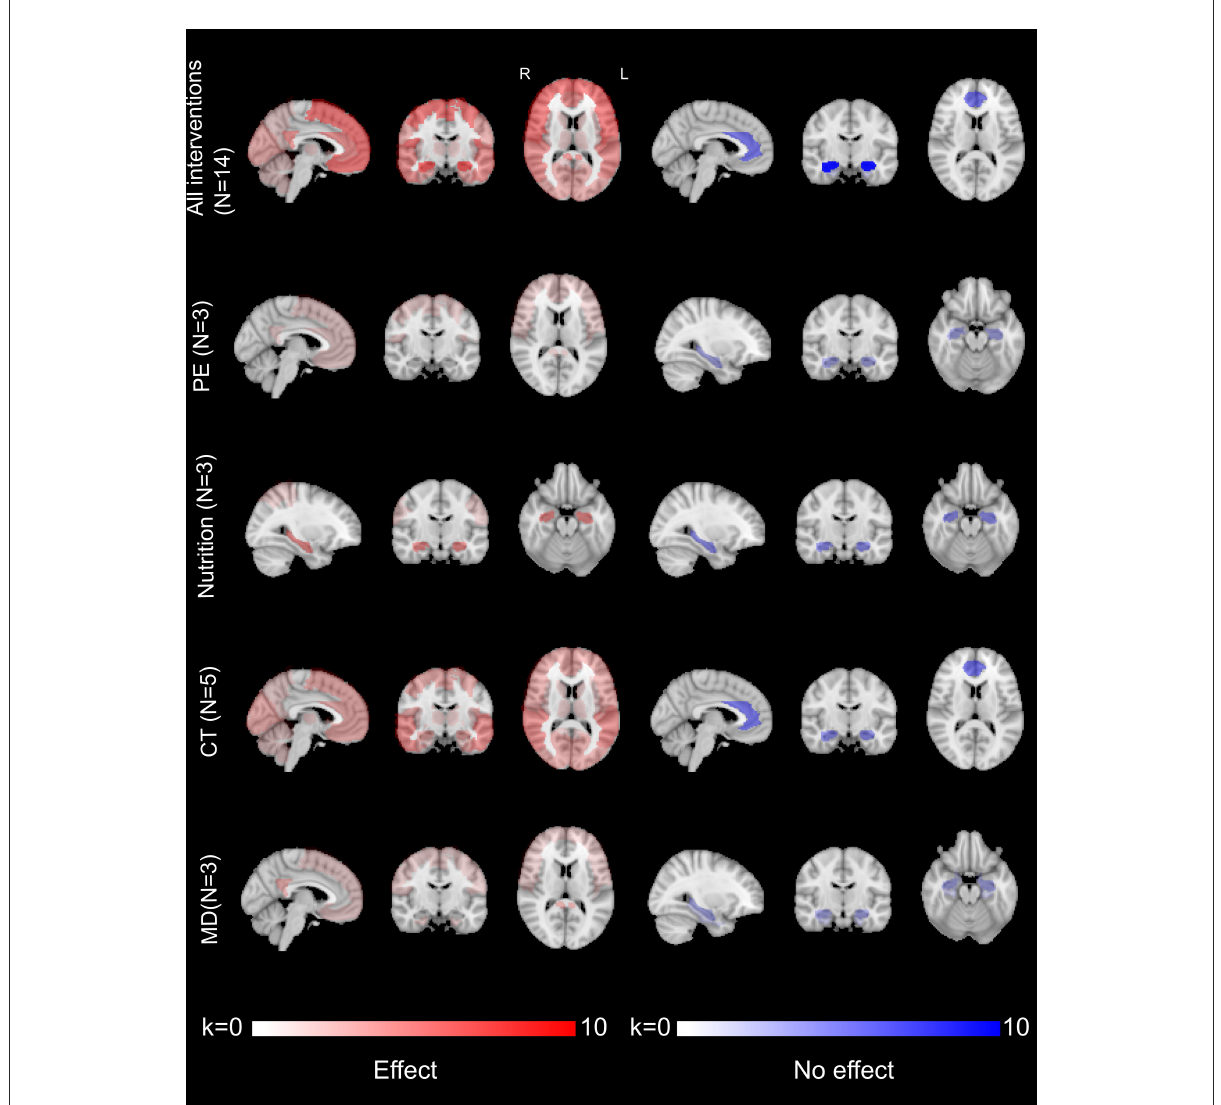
FIGURE3 Brain regions affected by the interventions for participants with CI, for all imaging modalities and after direct comparison to a sham intervention. Color grading is used to display the number of results (k), positive (effects of interventions on brain regions through whole-brain or region-targeted analyses; on the left in red) or null (lack of effect of interventions after brain regions have been specifically targeted; on the right in blue), over brain regions. Please refer to the Supplementary Figure 2 for the count of results (k) for each named regions. CT, cognitive training; k, number of results; MD, multidomain